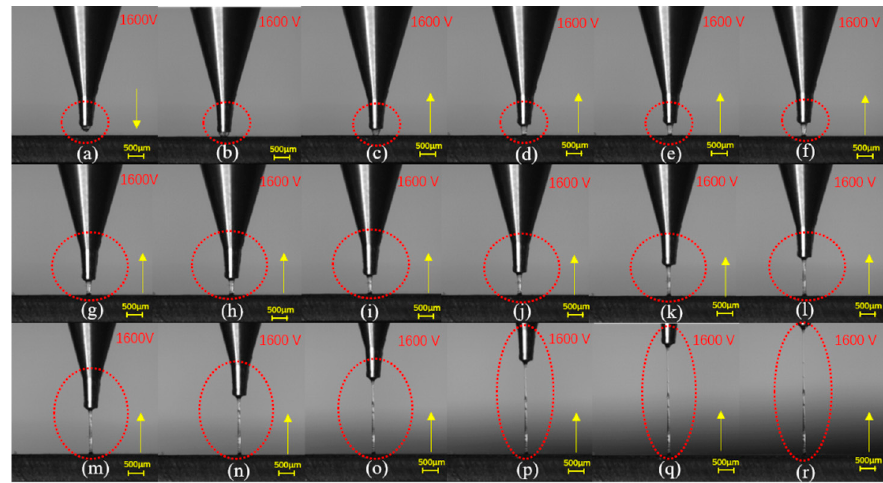
Figure 5. Vertical tensile morphology of jet at 1600 V DC voltage. ( a ) the meniscus initially formed at the bottom of the nozzle; ( b ) the PCL material at the bottom was bonded to the surface of the deposited substrate; ( c – f ) the nozzle moved upward, the jet shape and size shows a weak taper change; ( g – n ) the overall diameter size of the jet gradually decreases; ( o – r ) the obvious diameter reduction occurs at the upper end of the jet near the nozzle.